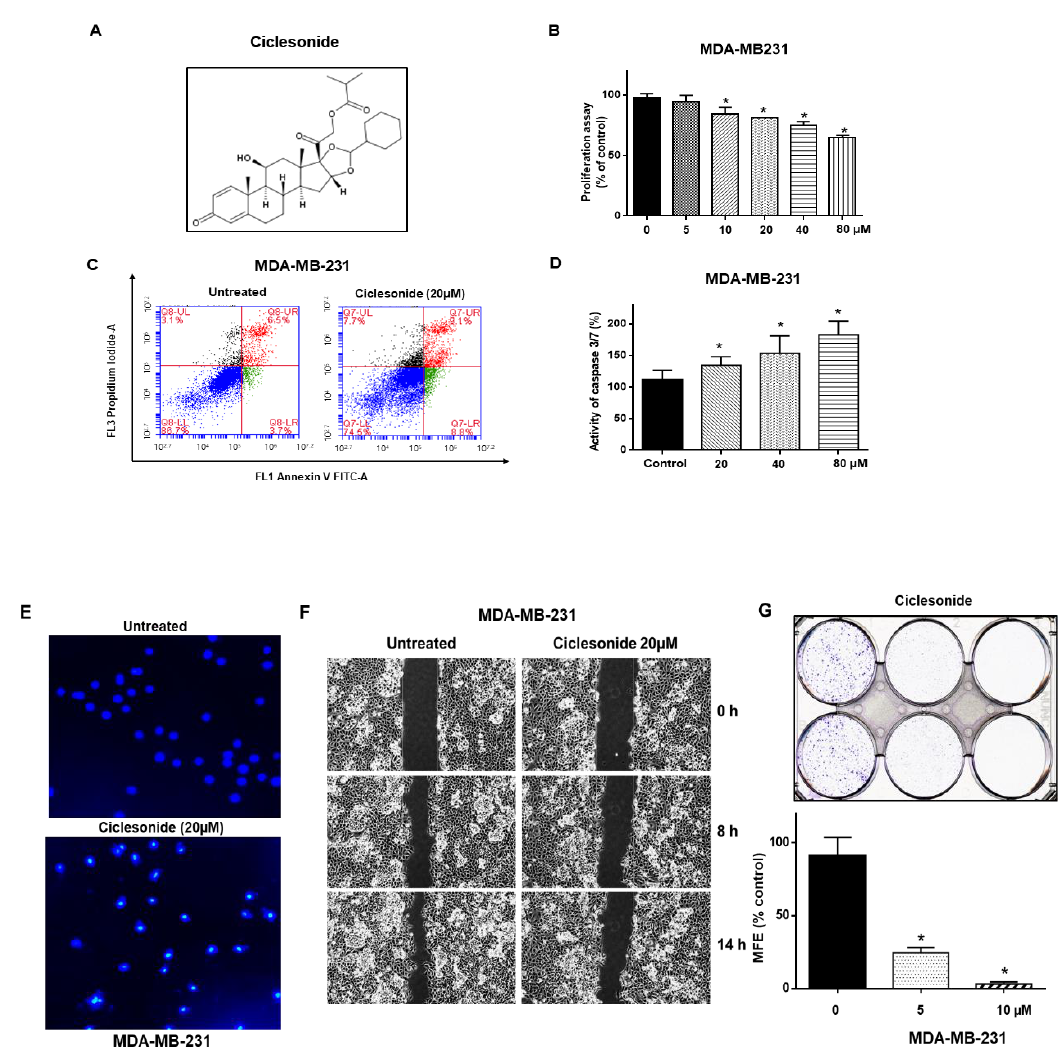
Figure 1. Ciclesonide reduces the proliferation of MDA-MB-231 cells. ( A ) The chemical structure of ciclesonide.( B )MDA-MB-231cellswereculturedinaplatewiththeciclesonide.Theproliferationofcancercells ciclesonide. ( B ) MDA-MB-231 cells were cultured in a plate with the ciclesonide. The proliferation of wasassessedwith3-(4,5-Dimethylthiazol-2-yl)-5-(3-carboxymethoxyphenyl)-2-(4-sulfophenyl)-2 H -tetrazolium cancer cells was assessed with 3-(4,5-Dimethylthiazol-2-yl)-5-(3-carboxymethoxyphenyl)-2-(4- (MTS) reagent. ( C ) Ciclesonide (20 µ M) induced the apoptosis of MDA-MB-231 cells. Apoptosis was assayed sulfophenyl)-2 H -tetrazolium (MTS) reagent. ( C ) Ciclesonide (20 μM) induced the apoptosis of MDA- using Annexin V / Propidium Iodide (PI) staining. ( D ) Caspase 3 / 7 activity was measured with a Caspase-Glo MB-231 cells. Apoptosis was assayed using Annexin V/Propidium Iodide (PI) staining. ( D ) Caspase assaykit(Promega,Madison,WI,USA).Ciclesonideincreasedcaspase3 / 3/7 activity was measured with a Caspase-Glo assay kit (Promega, Madison, WI, USA). Ciclesonide increased caspase3/7 activity in a concentration-dependent manner. ( E ) Ciclesonide (20 μM) induced